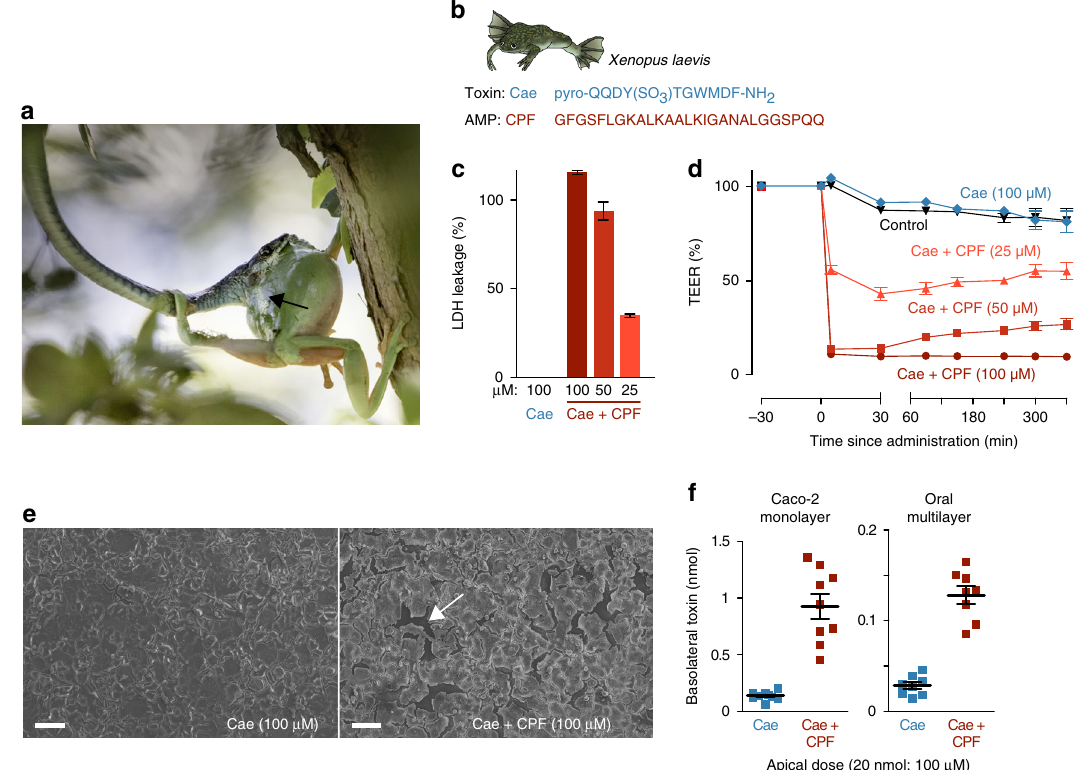
Fig. 1 A frog antimicrobial peptide promotes the transepithelial passage of a cosecreted toxin. a Litoria caerulea (an Australian tree frog) attacked by the snake Dendrelaphis punctulatus . Note the defensive skin secretion (black arrow), known to contain toxins (including caerulein) and AMPs (photograph taken by Jannie Smit). b Amino-acid sequences of the X. laevis skin toxin caerulein (Cae) and its cosecreted antimicrobial peptide, caerulein precursor fragment (CPF). c Lactate dehydrogenase (LDH) leakage indicates cell damage in a Caco-2 epithelial model exposed to a mixture of caerulein and CPF but not to caerulein alone ( n = 7; 100% corresponds to the LDH leakage caused by complete cell lysis as induced by Triton-X). d Co-administration of CPF induces a rapid prolonged drop in transepithelial electrical resistance (TEER) of Caco-2 monolayers ( n = 9, one-way ANOVA, F(4, 40) = 1345.6, p < 0.0005). e Caerulein alone does not damage Caco-2 monolayers, but co-administration of CPF results in intercellular ruptures (white arrow), as revealed by scanning electron microscopy. Scale bars represent 100 μ m. f Co-administration of CPF at the apical side leads to higher caerulein levels after 60 min at the basolateral side, indicating enhanced transepithelial transport across Caco-2 monolayers ( n = 9, t -test, t (8.2) = − 7.3, p < 0.0005) and an oral multilayer model ( n = 8, t -tests, t (9.1) = − 9.6, p < 0.0005). All data are mean ± s.e.m., error bars not shown when covered by data